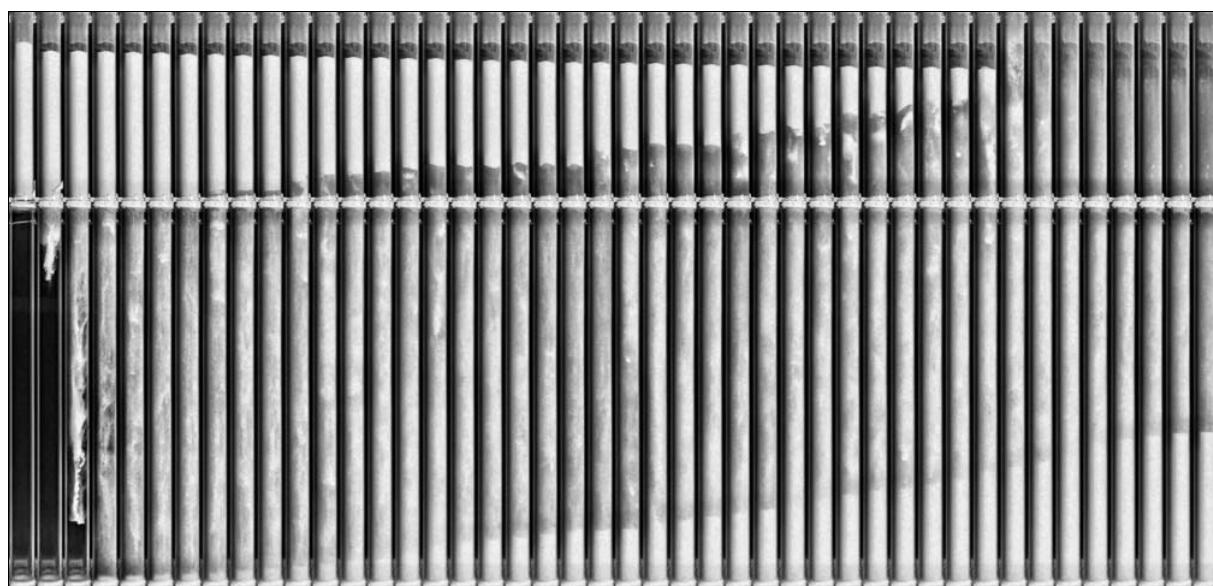
Figure 3. Sequence of 44 frames with 0.28 s time interval from the airtight closed pipe outlet experiment with microcrystalline cellulose (MCC102). The depicted experiment time: 12.32 s. The four distinctions of powder fall are clearly observable: the upper plug descends and the dis- crete detachment of material, the dispersion of the detached material in air, and the accumulation of sedimented material at the bottom of the pipe. The original images are inverted and contrast enhanced for illustration